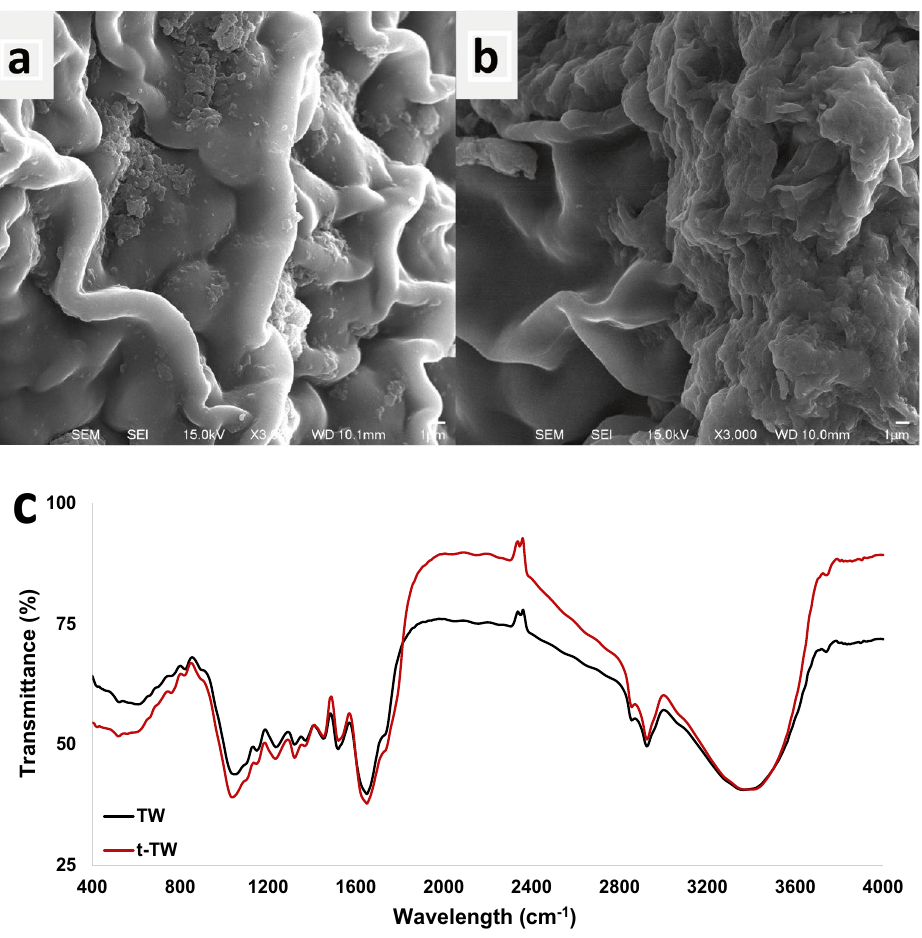
Figure 1. SEM of ( a ) tea waste (TW) and ( b ) treated tea waste (t-TW) modified with ascorbic acid. ( c ) FTIR spectra of the